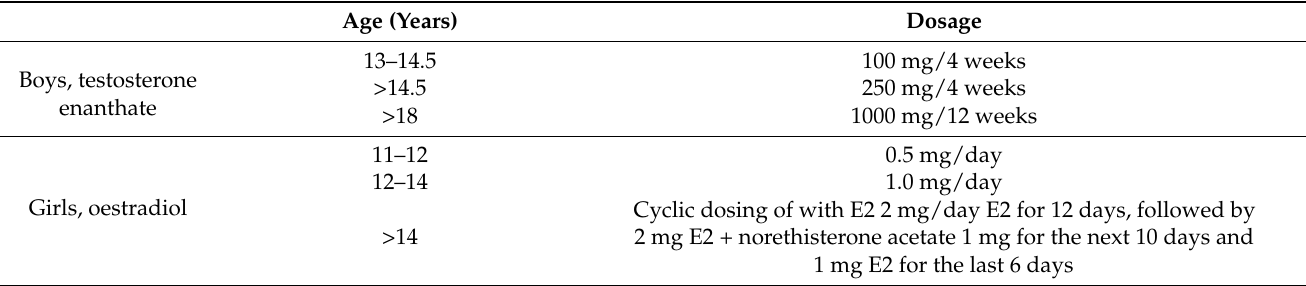
Table 1. Outline of our institutional sex steroid supplementation regimen to treat PWS patients after establishing pubertal arrest and hypogonadism.